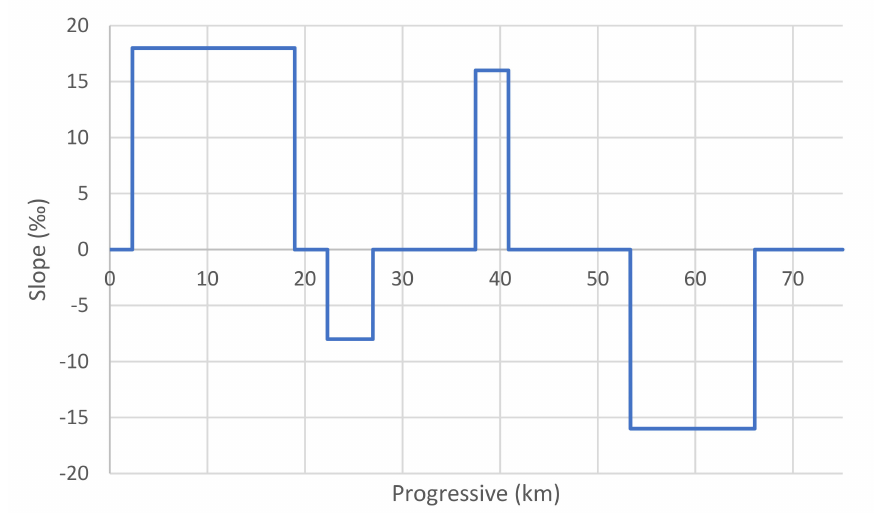
Figure 6. Slope of line.